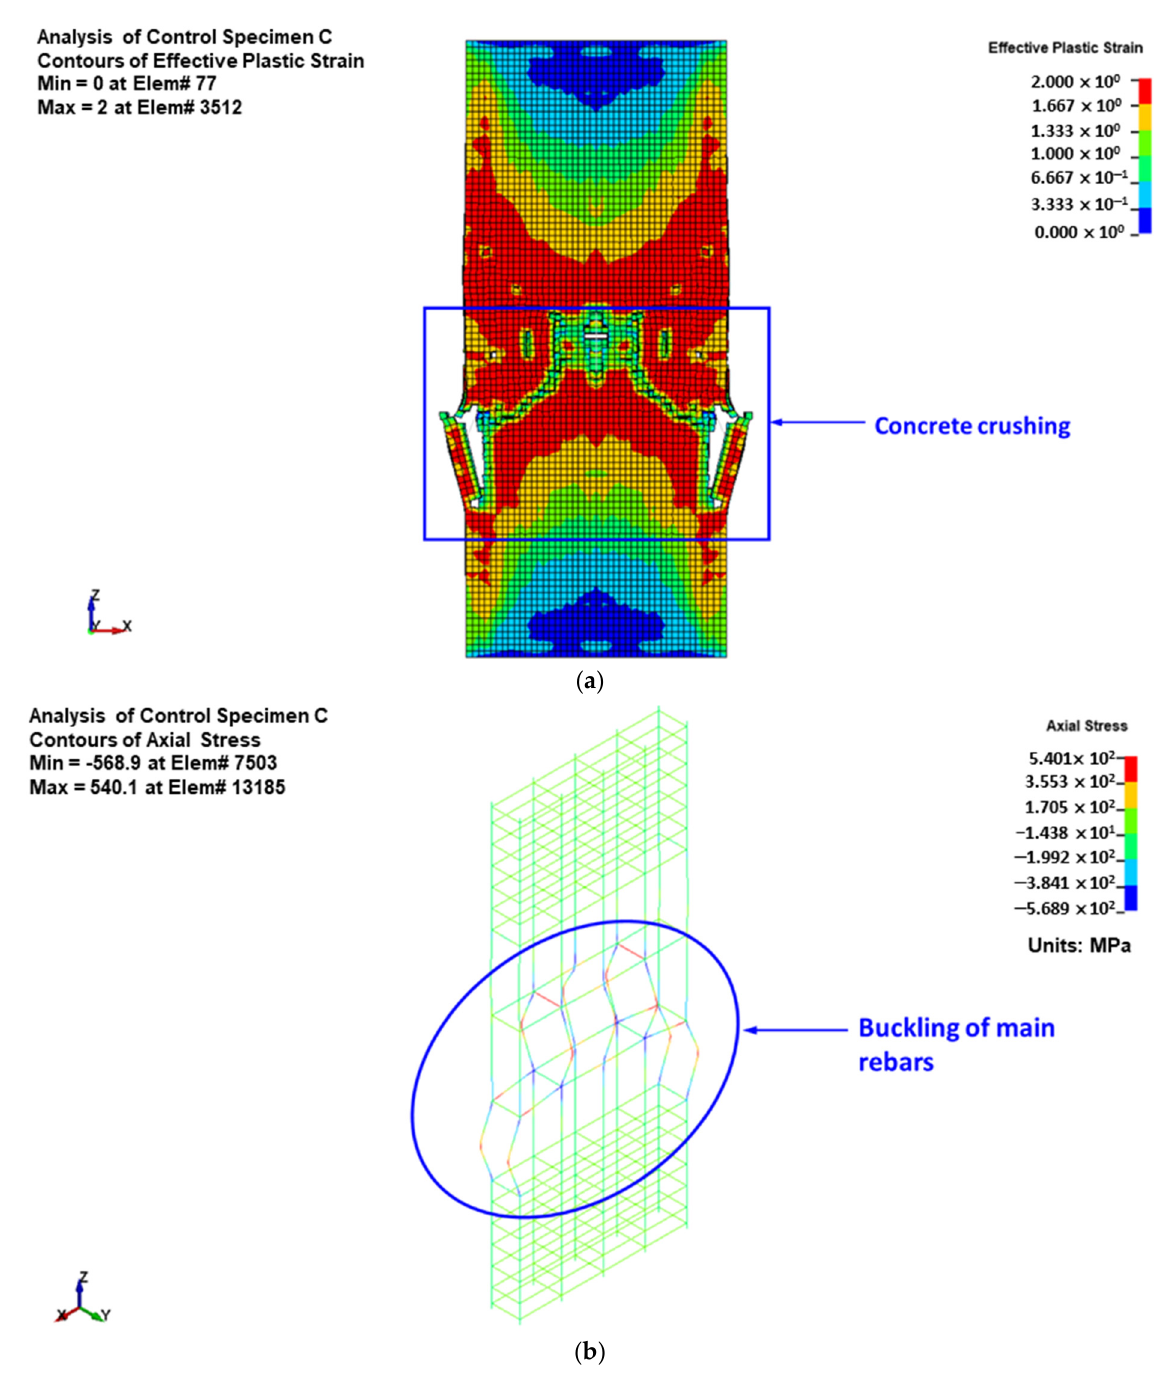
Figure 15. Numerically predicted failure mode for control column C: ( a ) concrete damage contours; ( b ) axial stress contours for reinforcement cage.